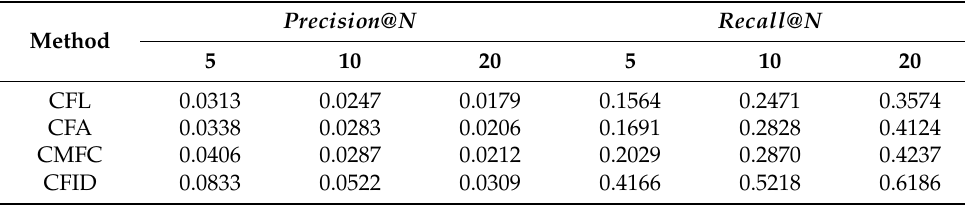
Table 4. Comparative results for two-person group on Tokyo dataset.